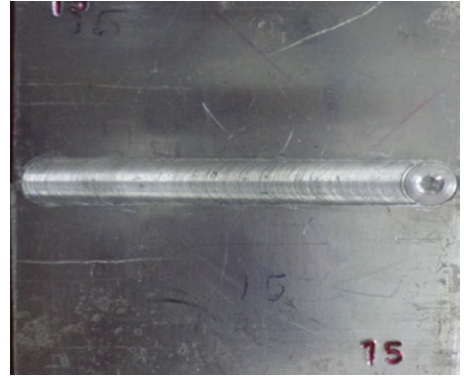
Figure 4: Photograph of fabricated FSW joint.